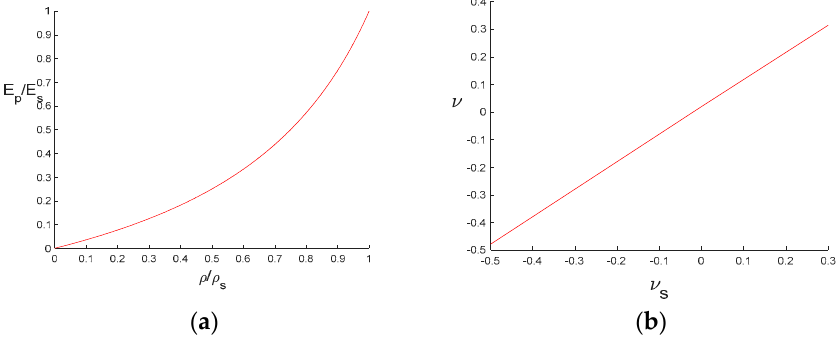
Figure 4. ( a ) The relationship of E P / E s and ρ / ρ s ; ( b ) the linear figure of ν against ν s ( ϕ = 0.07)